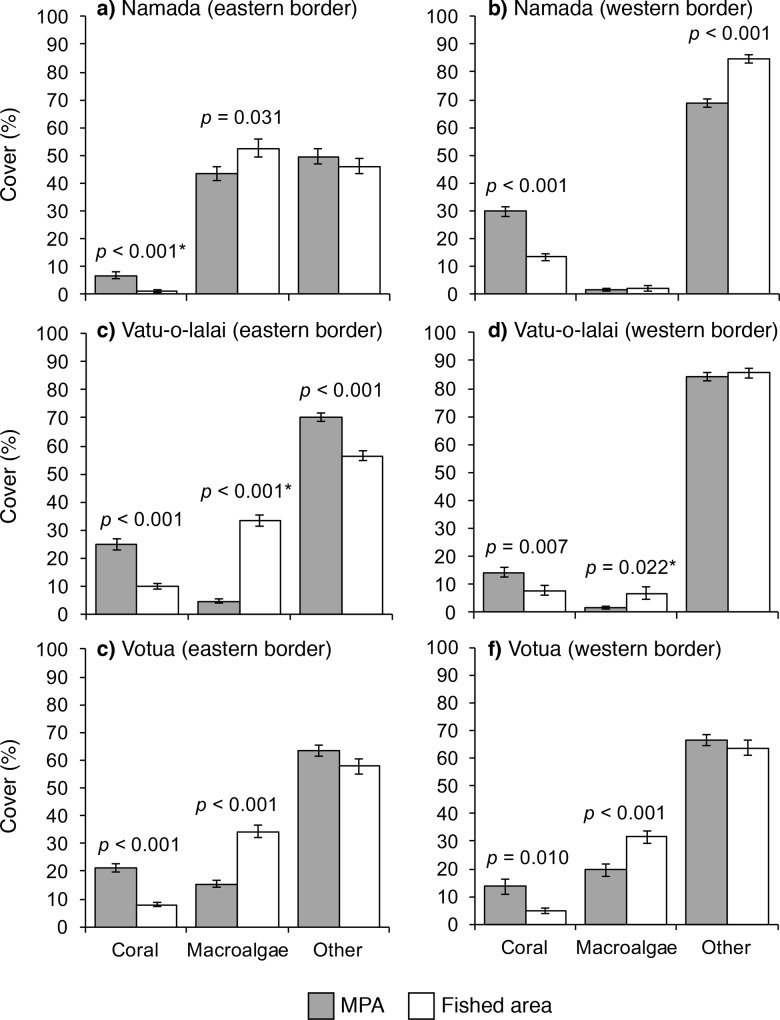
Reef habitat differs immediately inside vs. outside MPAs.Comparisons of benthic cover (mean % ± SE) 20 m inside (black) and 20 m outside (gray) of MPA borders perpendicular to the coastline at Namada, Vatu-o-lalai, and Votua villages (n = 20 transects border-1 location-1). The category “Other” includes dead coral, rock, rubble/sand, and uncommon benthic organisms (e.g., zooanthids, soft coral). Asterisks after p-values indicate comparisons analyzed with quasi-GLM models.